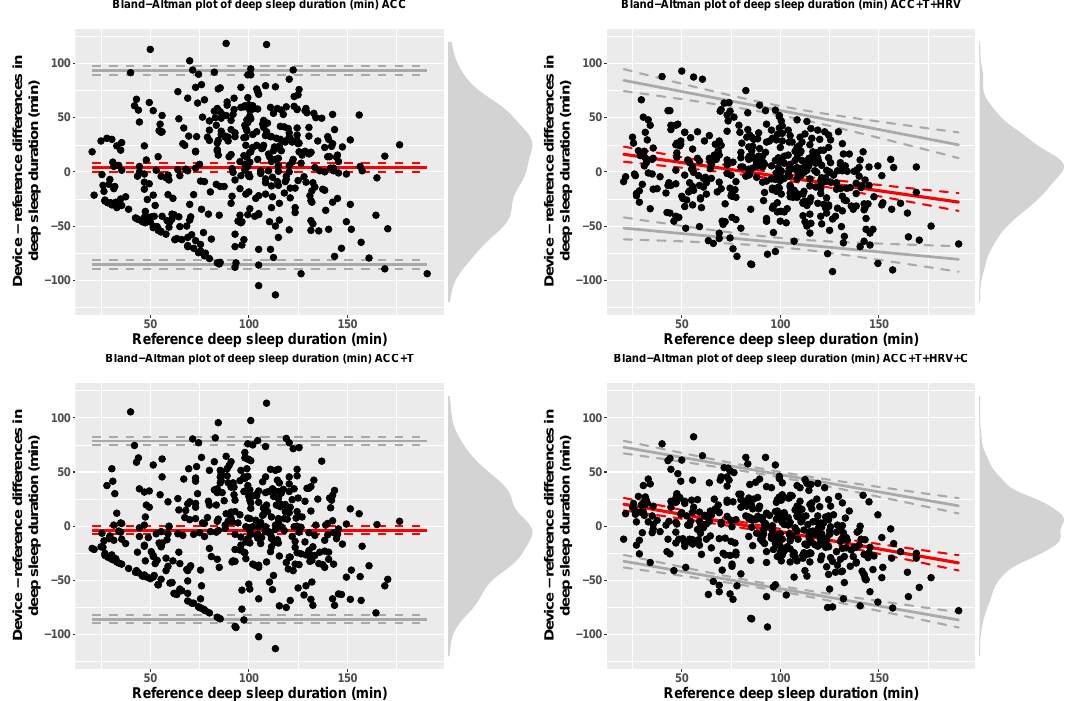
Figure 9. Bias and limits of agreement for time in deep sleep, 4-stage classification, and the four models analyzed in this